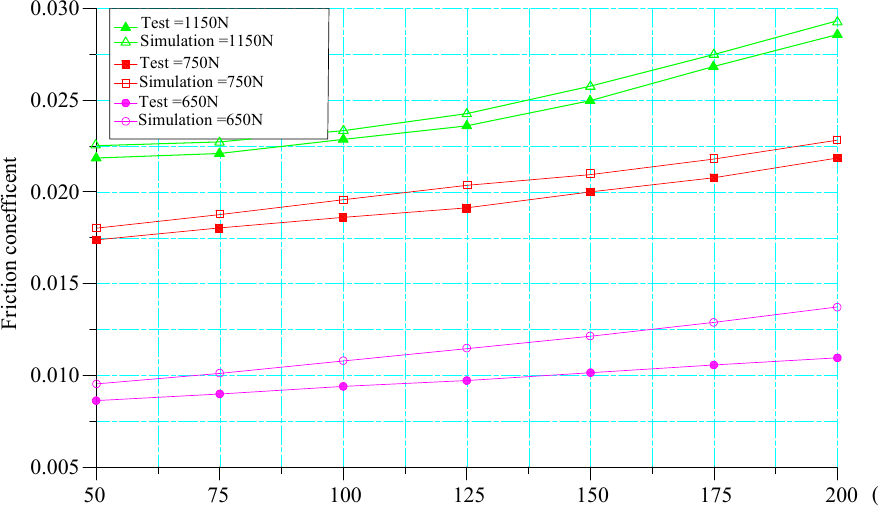
Figure 20. Comparison between friction coefficient and simulation results under smooth bearing test conditions.